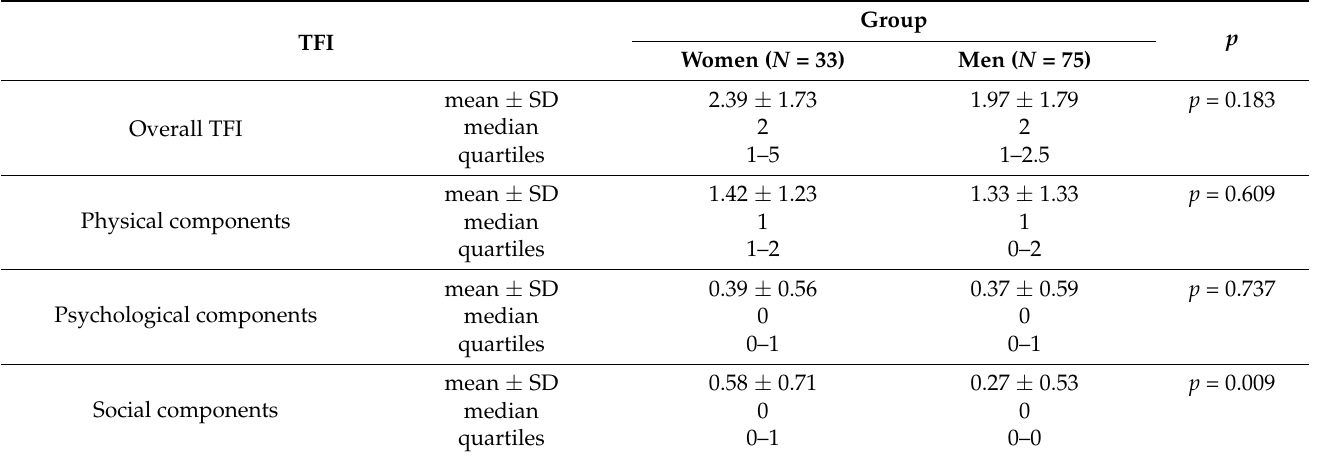
Table 2. Comparison of frailty syndrome domains in the group of men and